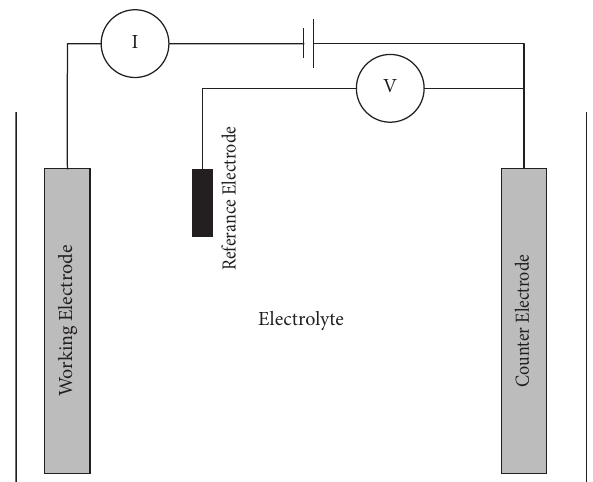
Figure 3: Schematic diagram of Electrodeposition